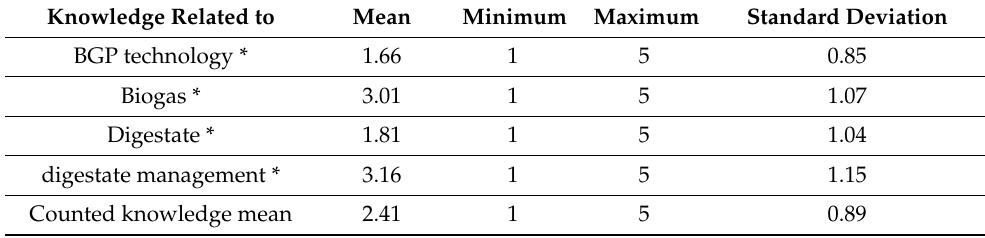
Table 4. Self-assessment of specific issues connected with biogas technology—BGP owners ( n =